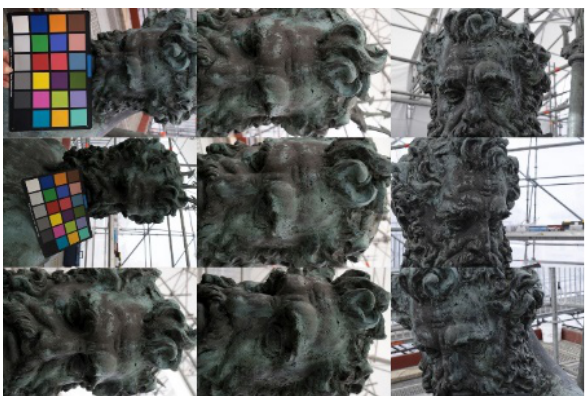
Figure 6. The Neptune head